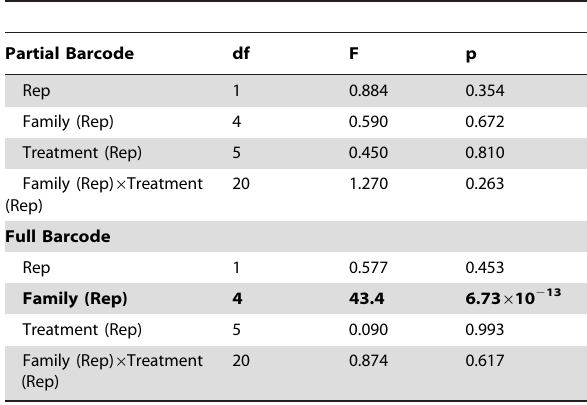
Table 5. Nested ANOVA results for treatment and family effects on amplification success.